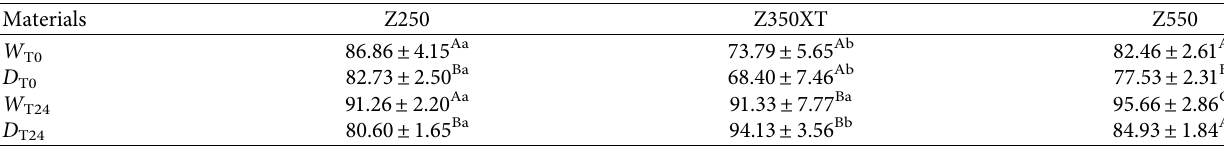
Table 5: Mean ± standard deviation (SD) values and result of comparison of hardness in three diferent composites in diferent polishing statuses (dry and wet) and times (0 and after 24hours).